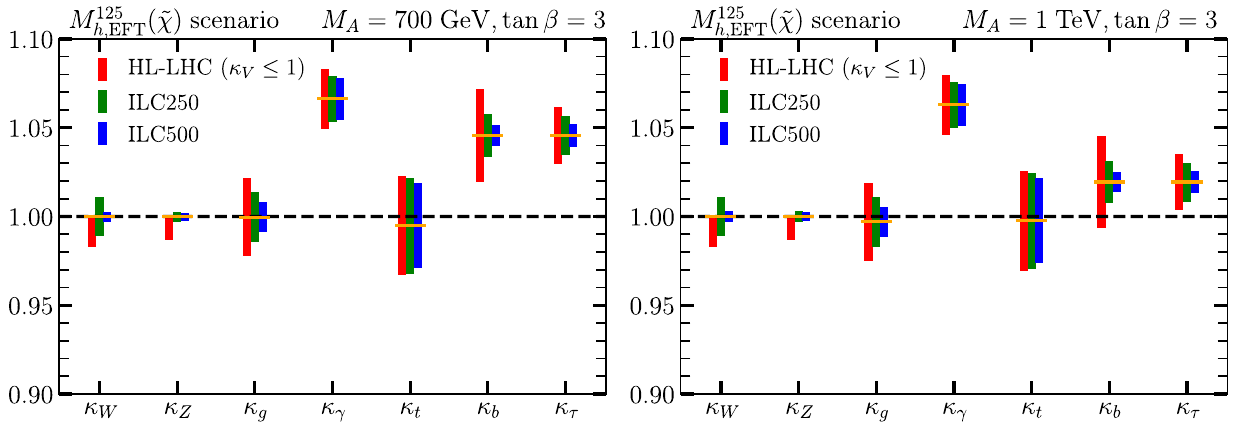
Fig. 14 Wäscheleinen-plots , using the same color coding as in work are compared with the anticipated 1 σ precision from Higgs rate Fig.9, for the two assumed MSSM parameter points ( M A , tan β) = measurements,whereattheHL-LHCthetheoreticalassumption κ V ≤ 1 ( 700GeV , 3 ) (left panel) and ( M , tan β) = ( 1TeV , 3 ) (right panel) in A ( ˜ χ) scenario. The predicted Higgs couplings in the κ frame- the M 125 h , EFT